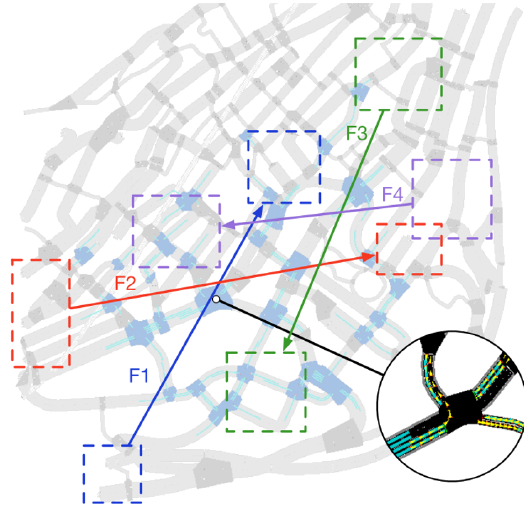
Figure 4. Monaco transport network with various